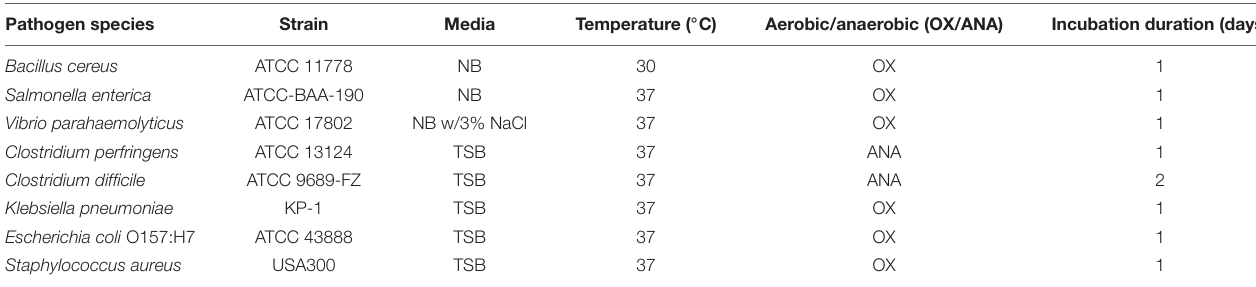
TABLE 1 | Growth conditions of